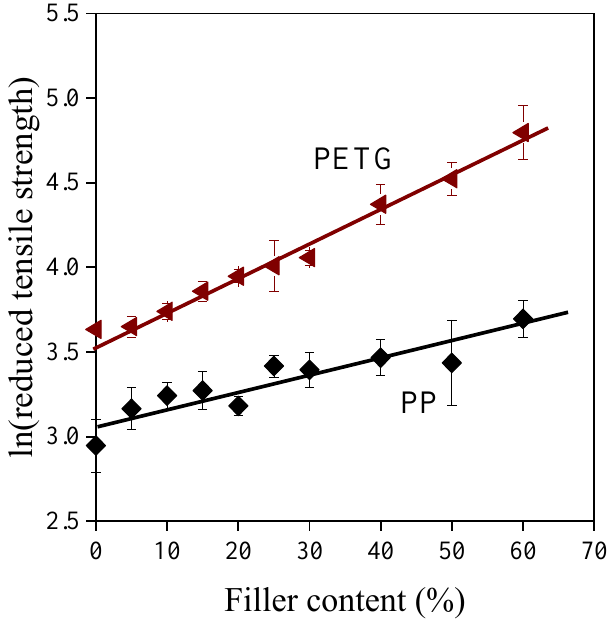
Figure 7. Reduced tensile strength of two composite series plotted against filler content in the form of Equation (7). Symbols: ( ) PP/SP20; ( ) PETG/SP20. Empty symbols represent data omitted from fitting. Table 3. Reinforcing effect of sunflower hull in the polymers studied. Matrix Polymer